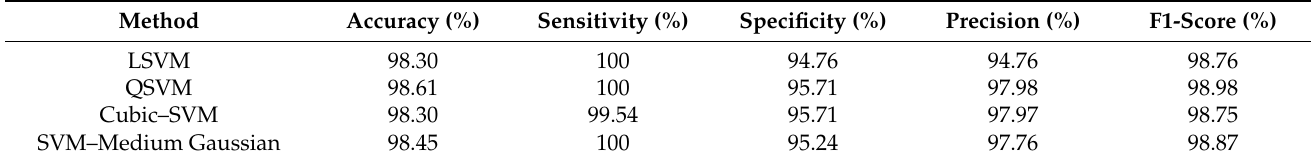
Table 6. DenseNet201 activated feature based classification using 10-fold cross validation.